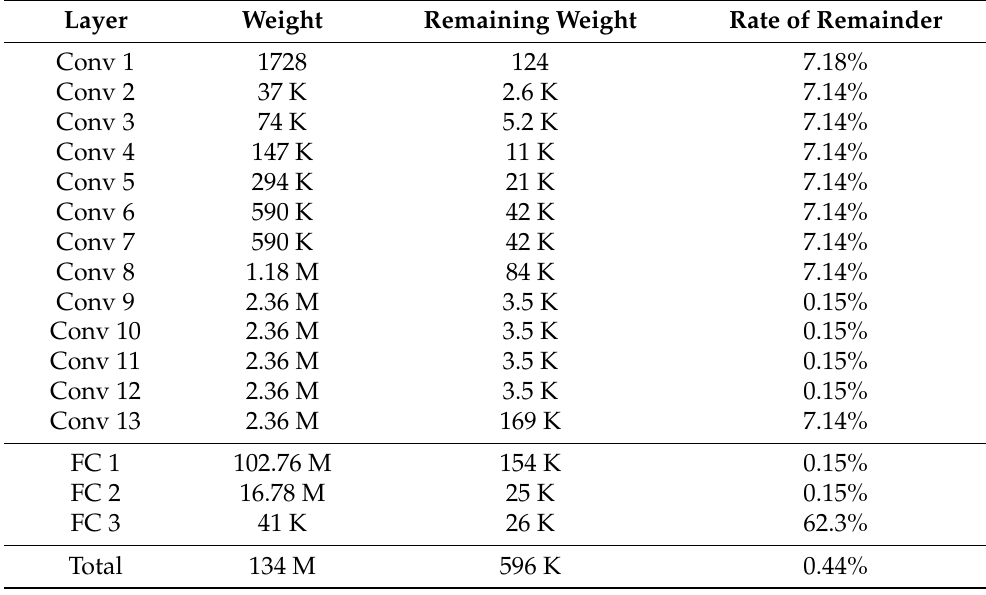
Table 2. Remaining weights and compression rate for each layer in